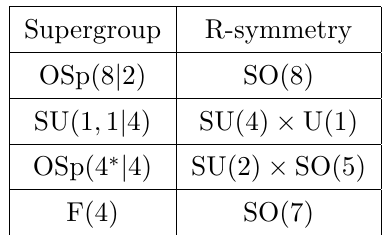
Table 2 . Superconformal algebras with N = 8 supersymmetry containing SO(1 ; 2) (cid:2) G R = ISO(AdS 2 ) (cid:2) G R . The various R-symmetry groups G R are realised geometrically in the corre- sponding supergravity duals. Therefore, the relevant one in our case is OSp(4 (cid:3) j